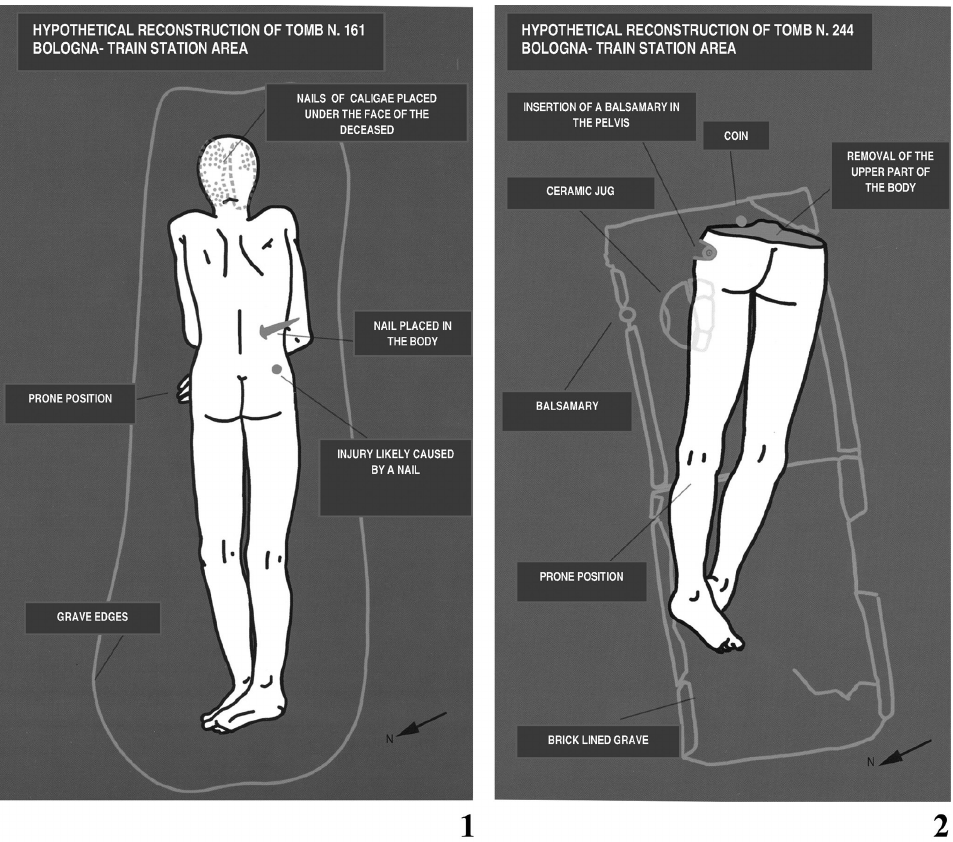
Figure 3: Reconstructions of anomalous graves from Aemilia region 1) Bologna, tomb no. 161, prone individual (after Cornelio-Cassai and Cavallari 2010: 101); 2) Bologna, tomb no. 244, mutilated individual with an insertion of an unguentarium in the pelvis (after Cornelio-Cassai and Cavallari 2010: